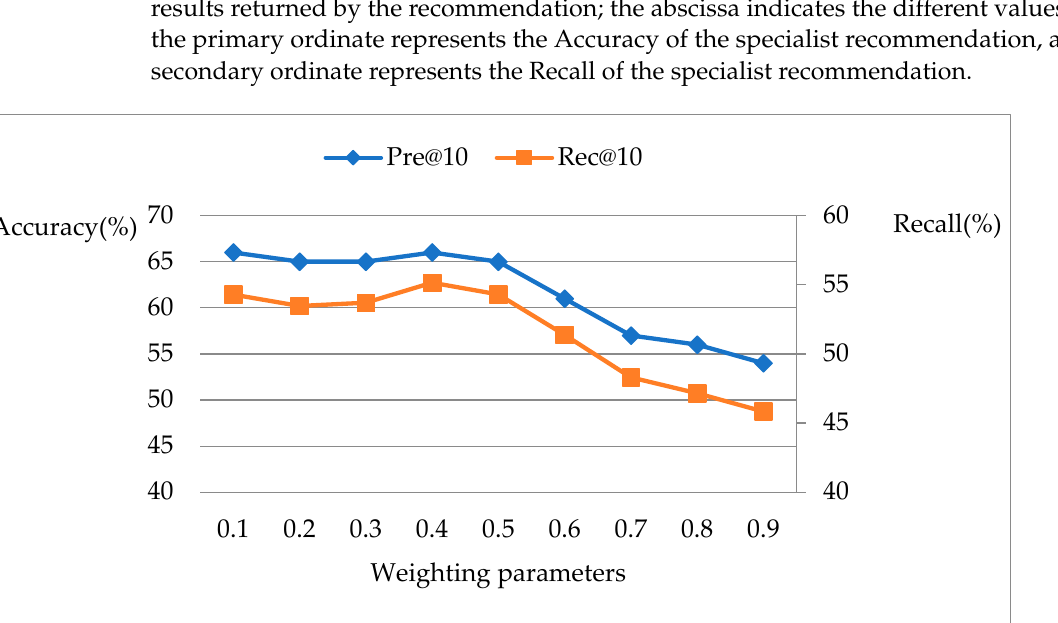
Figure 6. Performance of the hybrid recommendation model with different preferences.